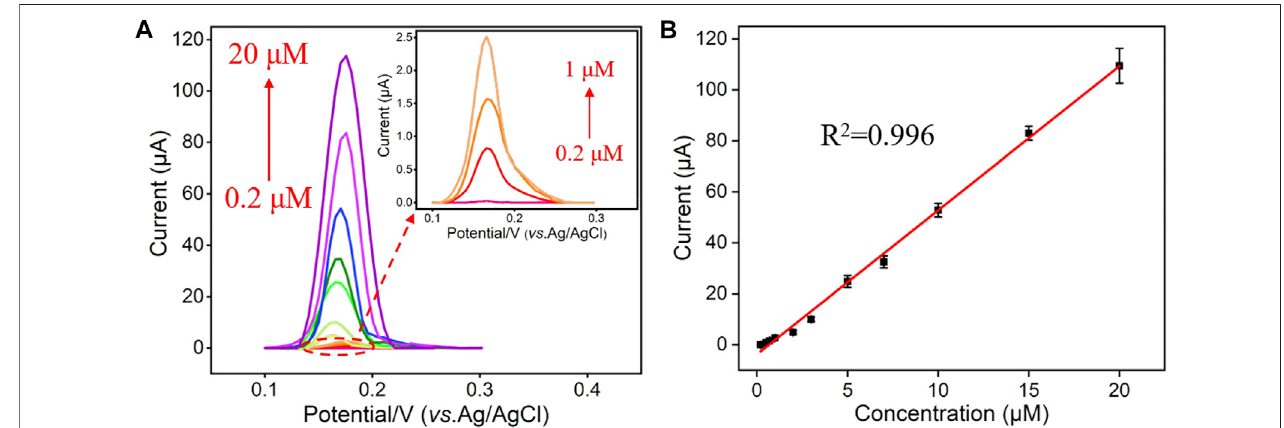
FIGURE 5 | (A) DPV curves obtained from the VMSF/ITO in response to different concentrations (0.2 μ M, 0.5 μ M, 0.7 μ M, 1 μ M, 2 μ M, 3 μ M, 5 μ M, 7 μ M, 10 μ M, 15 μ M, and 20 μ M) of Hg 2+ . (B) The dose response curve of Hg 2+ and the error bars represent the SD of three measurements.